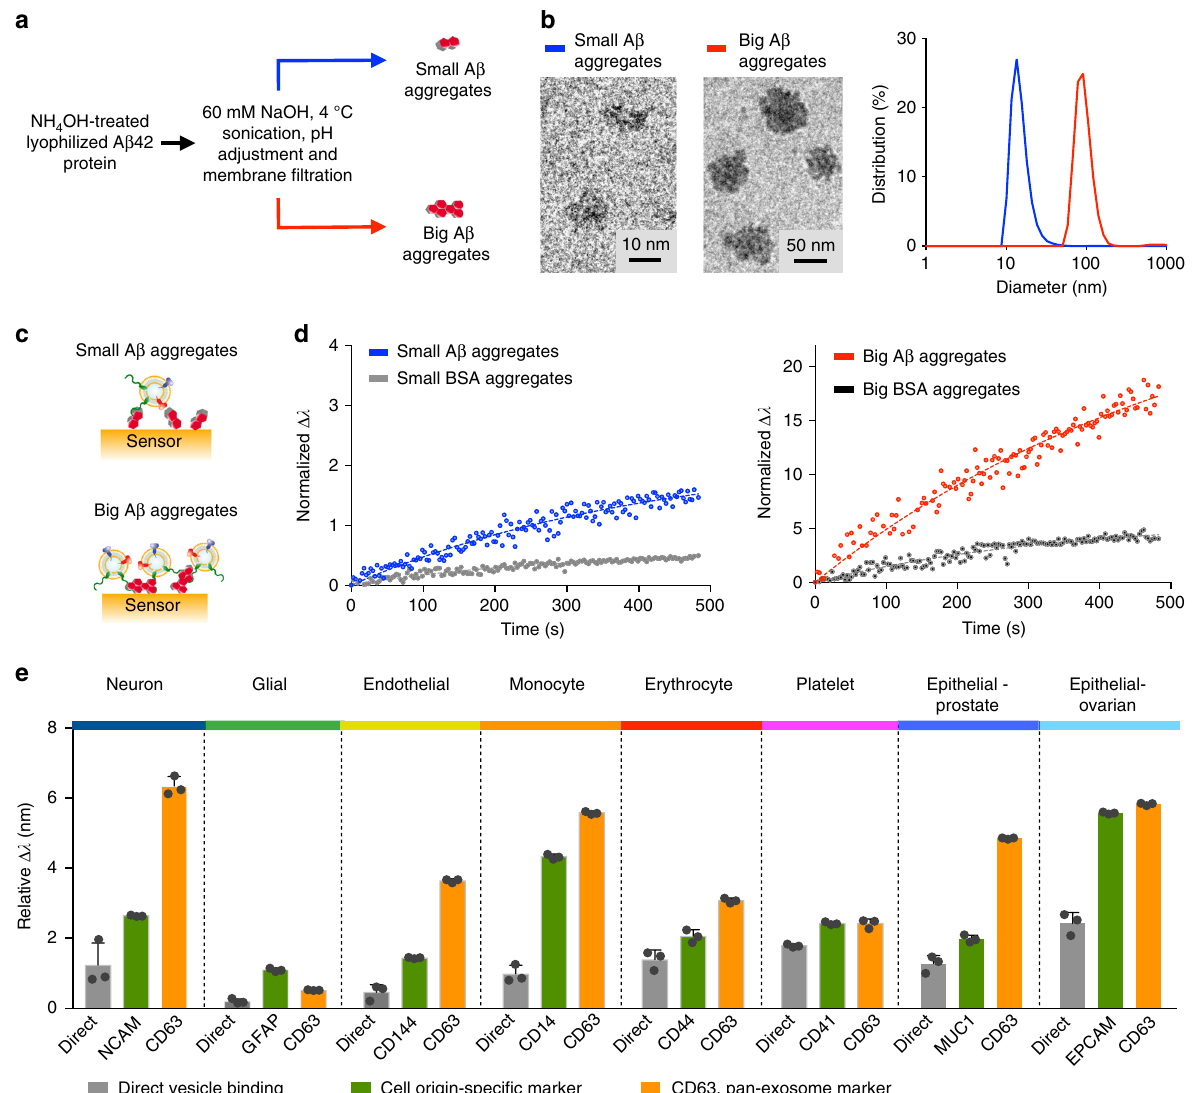
Fig. 3 Preferential association between A β aggregates and exosomes. a Schematics of A β protein aggregation. We varied the degree of clustering and used fi ltration approaches to prepare small and big A β 42 aggregates, respectively. b Characterization of A β protein aggregates. (Left) Transmission electron micrographs showed globular morphology of the prepared A β 42 aggregates. (Right) Dynamic light scattering analysis con fi rmed the unimodal size distribution of the different-sized preparations. c Schematics of the exosome-A β association analysis. A β 42 aggregates (small vs. big) were immobilized onto the APEX sensors and treated with equal concentrations of exosomes derived from neuronal cells (SH-SY5Y) to determine the association kinetics. All exosome binding data were normalized against respective A β 42 aggregate surface areas immobilized onto the sensors (see Methods for details).